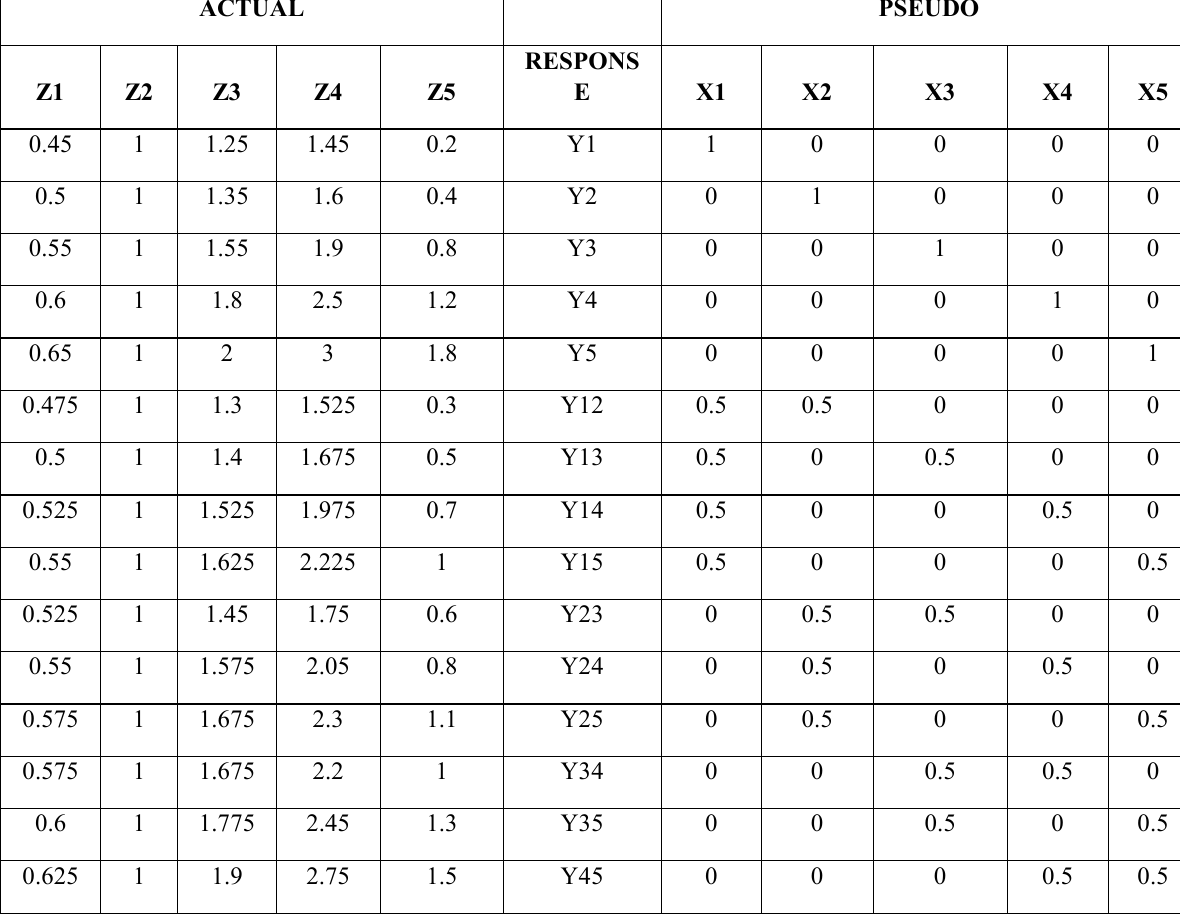
Matrix Table for Scheffe’s {5, 2} - Lattice Polynomial for Compressive Strength Test. ACTUAL